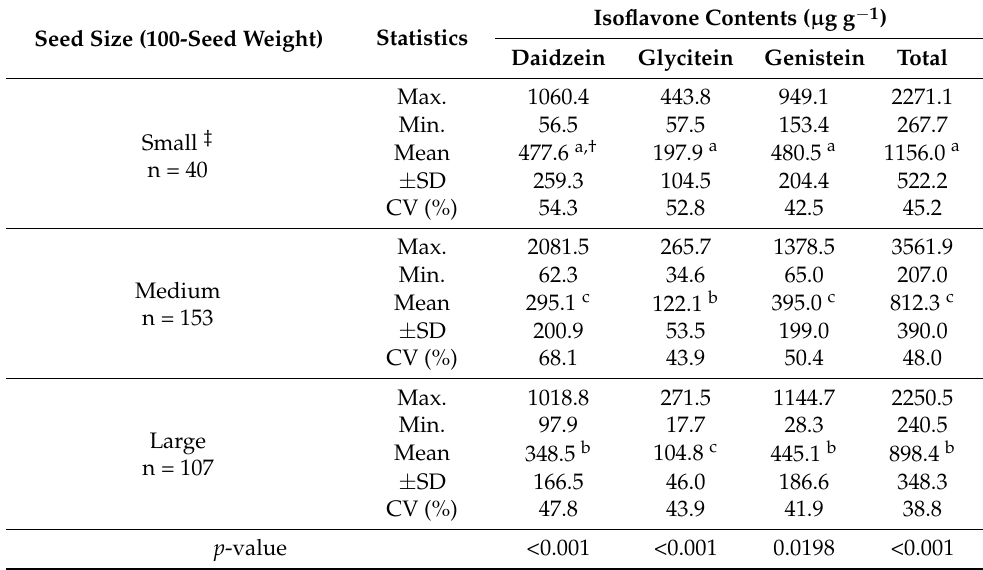
Table 6. Maximum, minimum and mean value of isoflavone contents according to seed sizes in 300 soybean